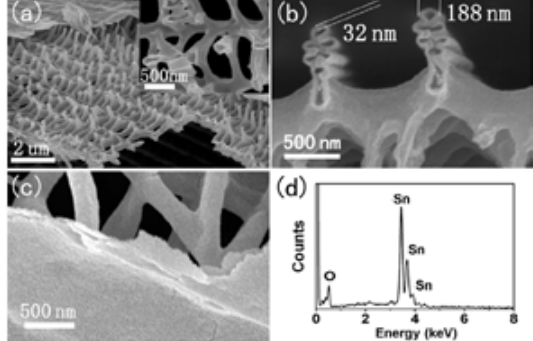
Fig. 12 FESEM images of (a) the inverse side of a sin- gle SnO scale with a region of the substrate 2 layer removed, the inset showing the hollow interiors of the pillars, (b) the cross section of the SnO scale, (c) the substrate layer with a 2 double-layered structure; (d) the EDX spectra of the SnO 2